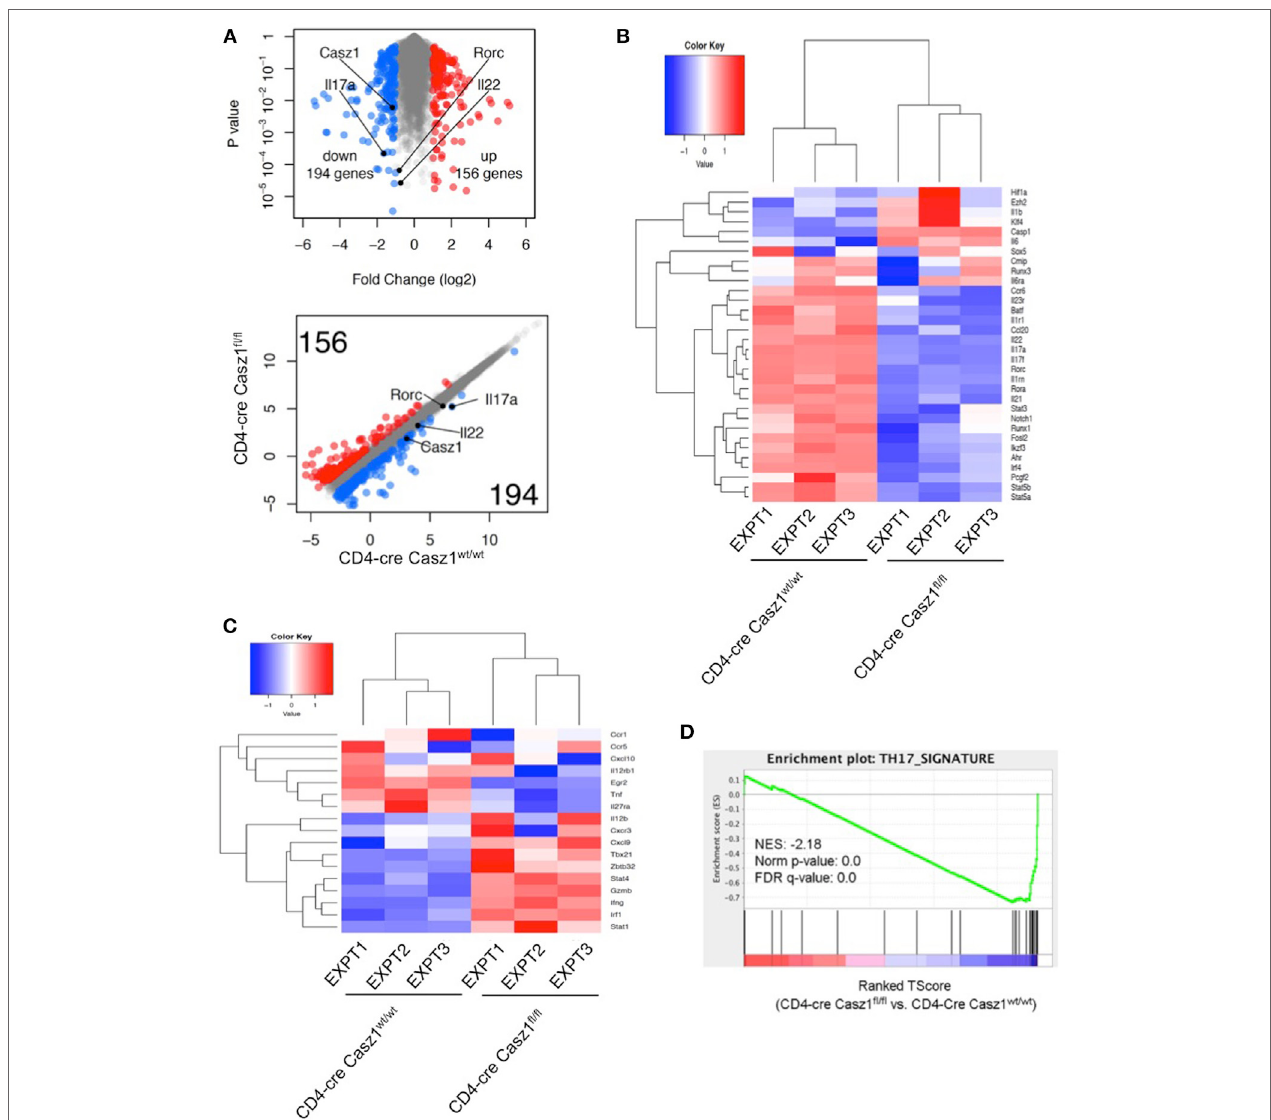
FigUre 6 | RNA sequencing (RNA-seq) analysis shows that Casz1 favors Th17 specification program. Volcano plot [ (a) , top], Scatter plot [ (a) , bottom], and heat maps of genes encoding literature curated Th17 signature proteins (B) and Th1 regulatory proteins (c) , derived from RNA-seq analysis comparing partially polarized CD4-cre Casz1 fl/fl Th17 cells and CD4-cre Casz1 wt/wt Th17 cells. Th17 and Th1 signature genes were defined based on the published literature. In (B,c) , the upper dendrograms illustrate the results of unsupervised hierarchical clustering of all six samples based on the expression of these Th17 signature genes. (D) Gene